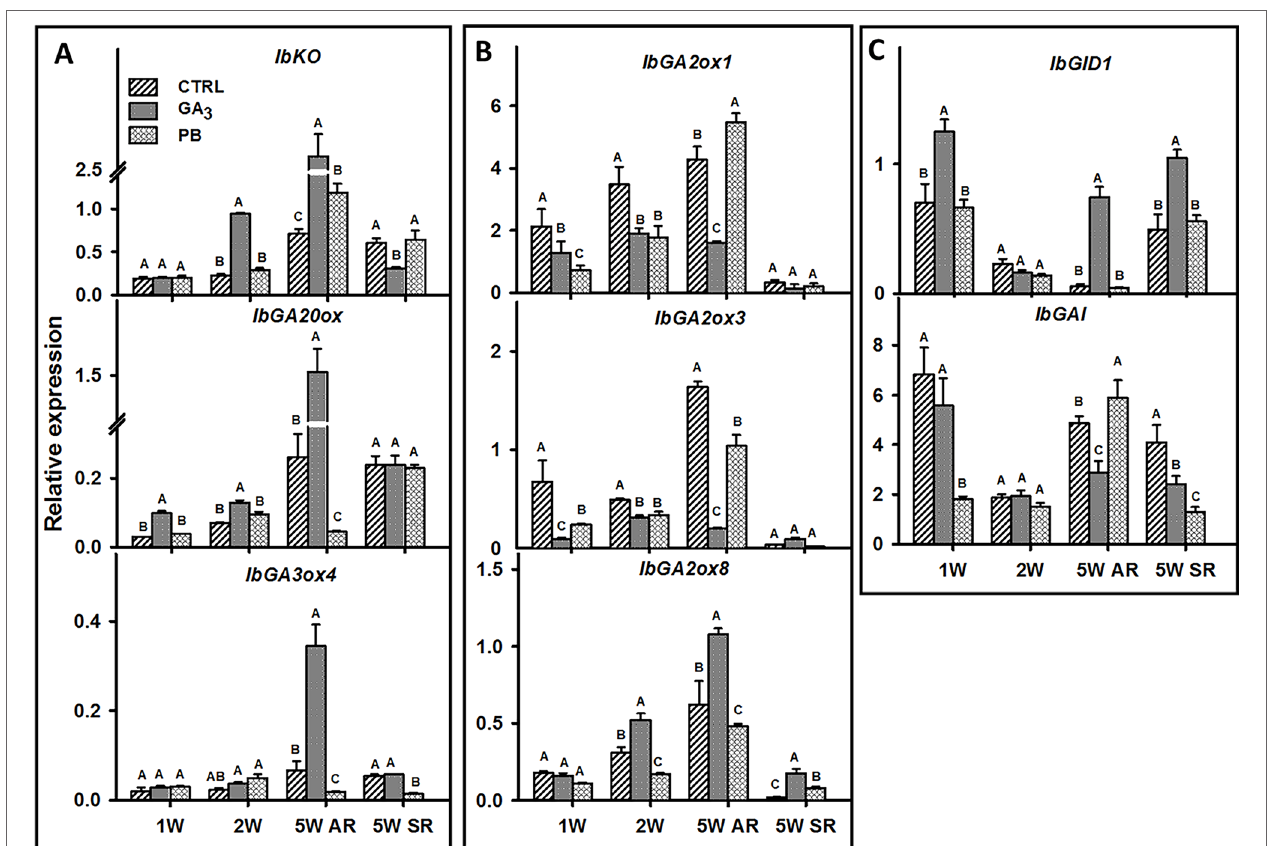
FiGURe 8 | The effect of GA 3 application on expression profiles of sweetpotato “ Georgia Jet ” orthologs/genes involved in gibberellin biosynthesis (a) , catabolism (B) , and signaling/regulation (c) in adventitious roots (AR) and storage-roots (SR). Expression/transcript levels were measured at 1W, 2W, and 5W after planting for AR and at 5W for SR, using qRT-PCR analyses, and values were normalized relative to the expression levels of phospholipase D1a. qRT-PCR data are mean (± SE) of three independent biological replicates (each representing roots pooled from four plants). Significance analysis was performed by using student’s t-test ( P ≤ 0.05 ), where unlike letters represent significant differences between treatments within a group. Control (treated with water); GA 3 , application of 50 ppm gibberellic acid 3 for two weeks; PB, application of 5 ppm paclobutrazol for two weeks.